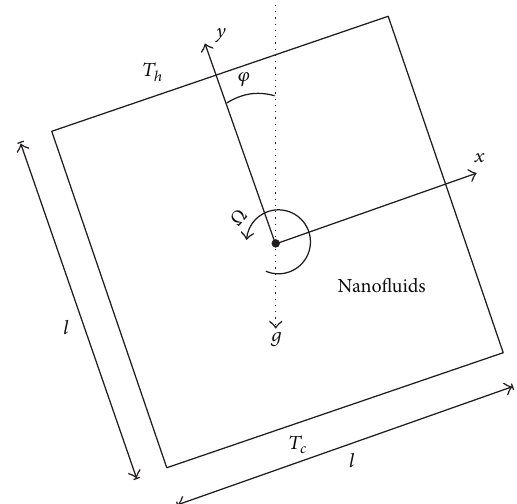
Figure 1: Schematic representation of the